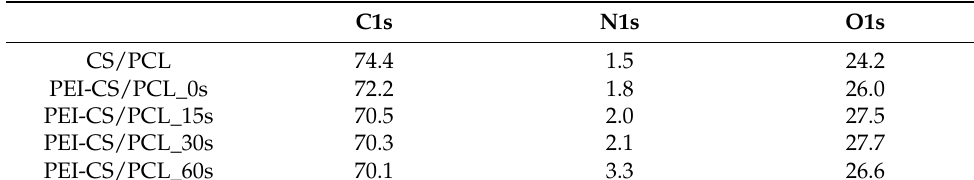
Table 1. XPS atomic concentration table for CS/PCL and PEI-CS/PCL.